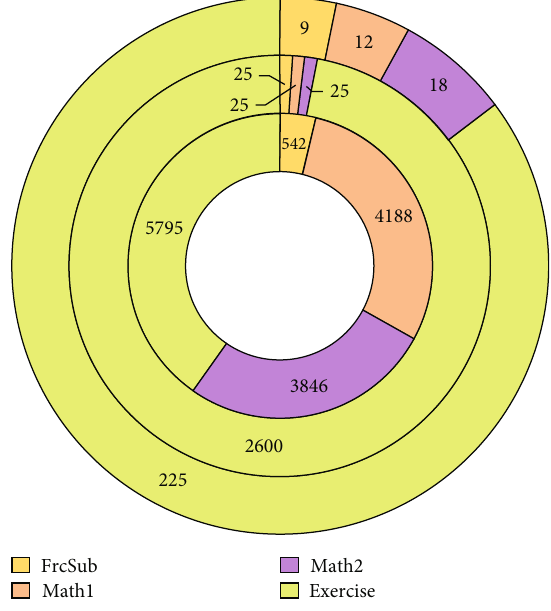
Figure 3: Details of four data